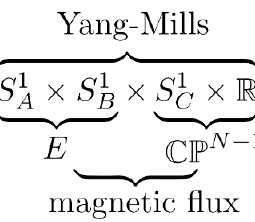
Figure 1 . We consider Yang-Mills theory on the geometry R (cid:2) S 1 E = S 1 (cid:2) S 1 is small, we obtain the two-dimensional CP N (cid:0) 1 -model in the remaining directions A B R (cid:2) S 1 . We include a unit ’t Hooft magnetic (cid:13)ux (i.e., twisting by the center symmetry) along C S 1 (cid:2) S 1 , which plays rather crucial roles in this B C